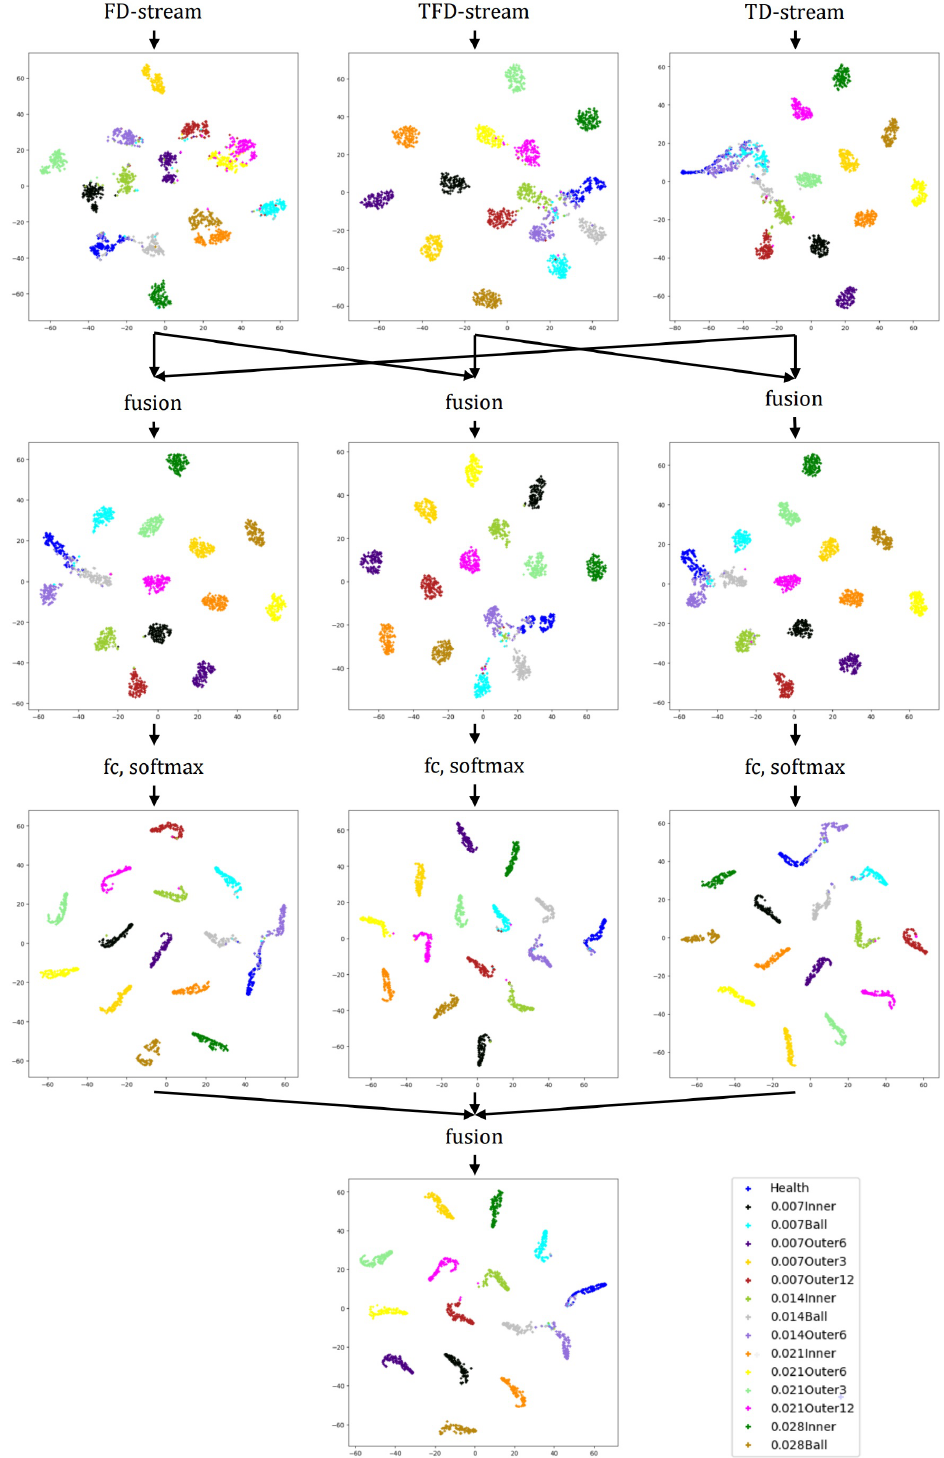
Figure 10. Feature maps visualization for CWRU with noise and trend